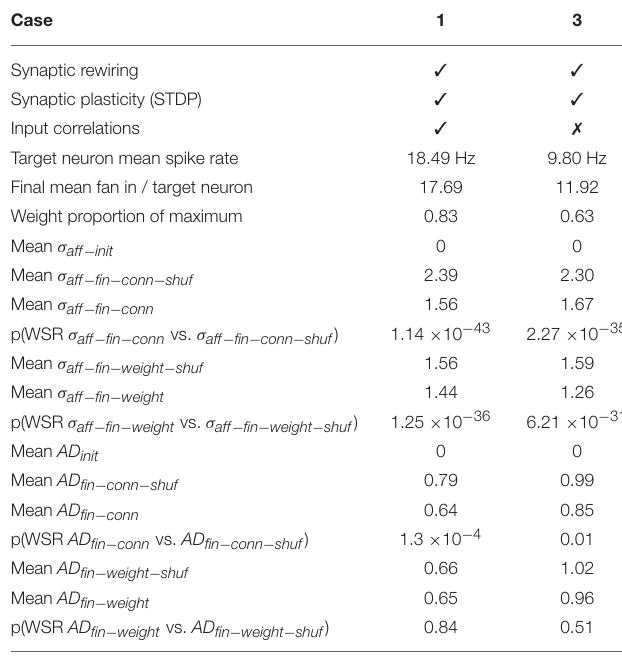
TABLE 3 | Results for modeling topographic map formation from development (minimal initial